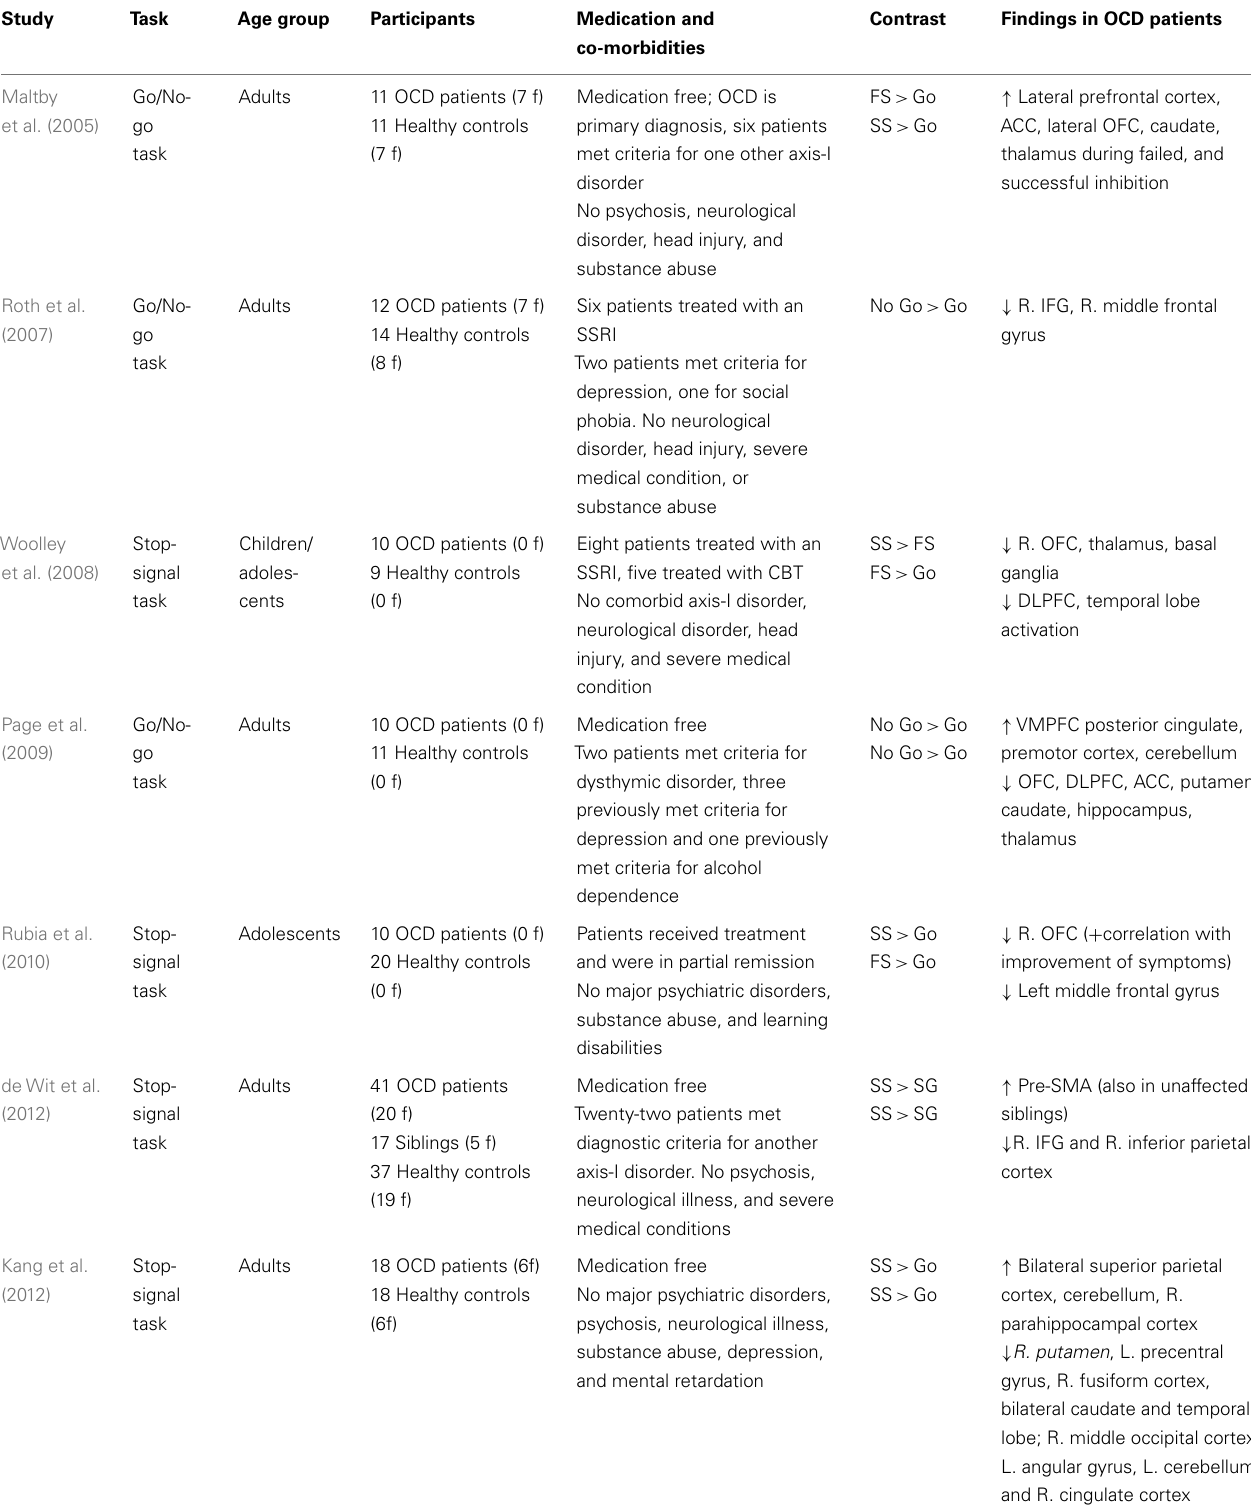
Table 2 | Overview of fMRI studies that have used response inhibition paradigms in obsessive–compulsive disorder